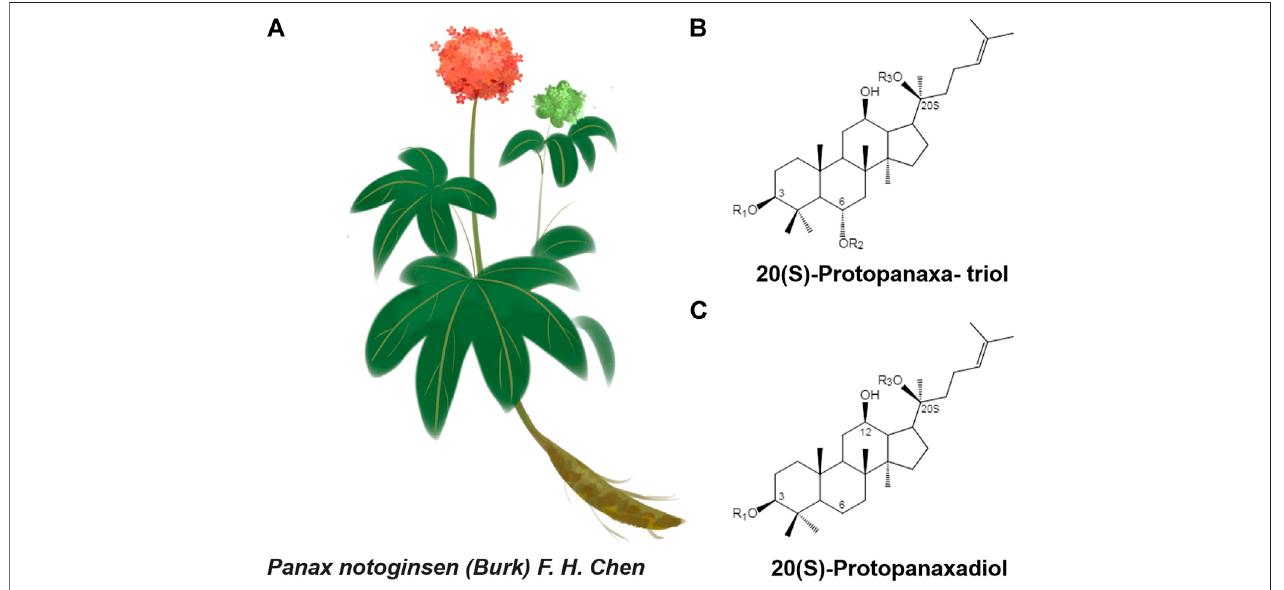
FIGURE1|(A) Panaxnotoginseng F.H.Chen (BandC) Structure skeletonsof20(S)-protopanaxatriol and20(S)-protopanaxadiolthatexistinrawandprocessed Panax notoginseng.